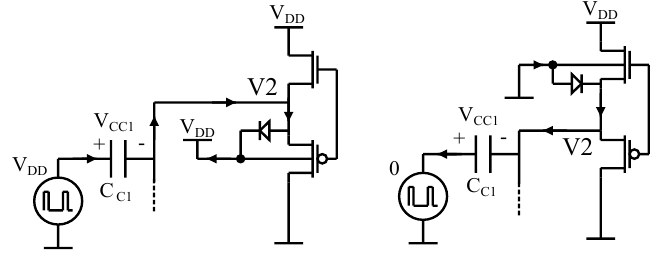
Figure 11. Turning on of the pn junctions of the MOSFET in the voltage